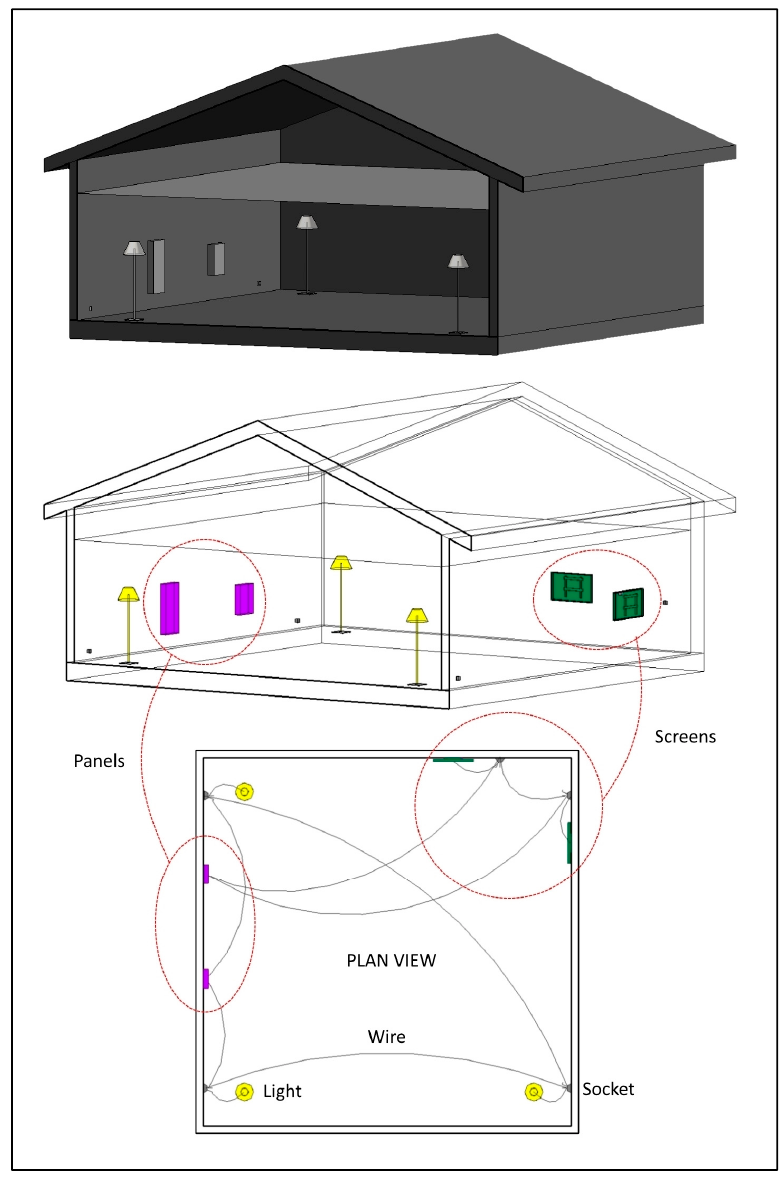
Figure 3. Building Information Modelling (BIM) model of the low-complexity, synthetic Building X with lights, screens, electric panels, electric sockets, and the cables that connect these